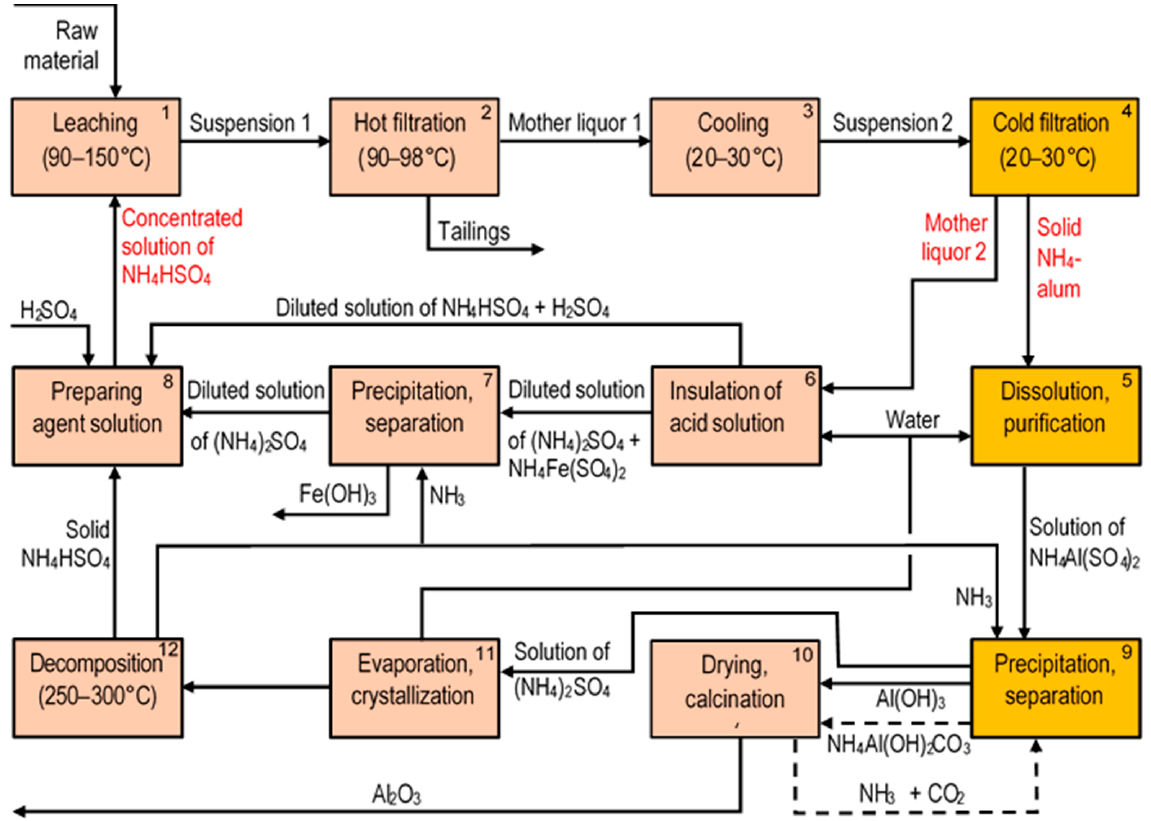
Figure 2. Principal flowchart of the closed-loop process for alumina production from low-grade (high-silica) raw materials by the hydrosulfate method.